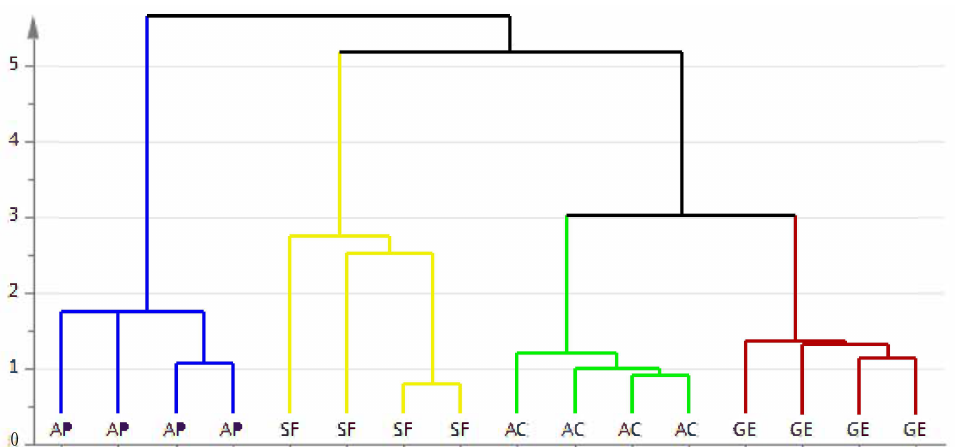
Figure 3. The dendrogram of the cluster analysis of stingless bee honey and Apis mellifera honey. AC = acacia honey; SF = starfruit honey; GE = gelam honey; AP = Apis mellifera